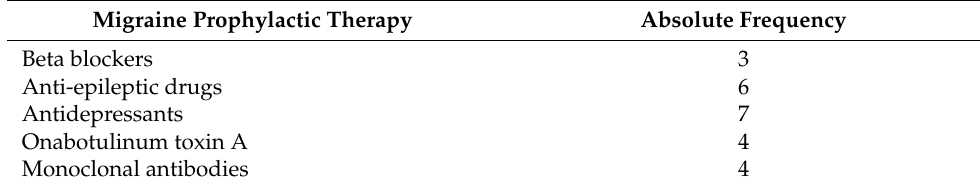
Table 2. Patients’ concomitant migraine prophylactic therapy during